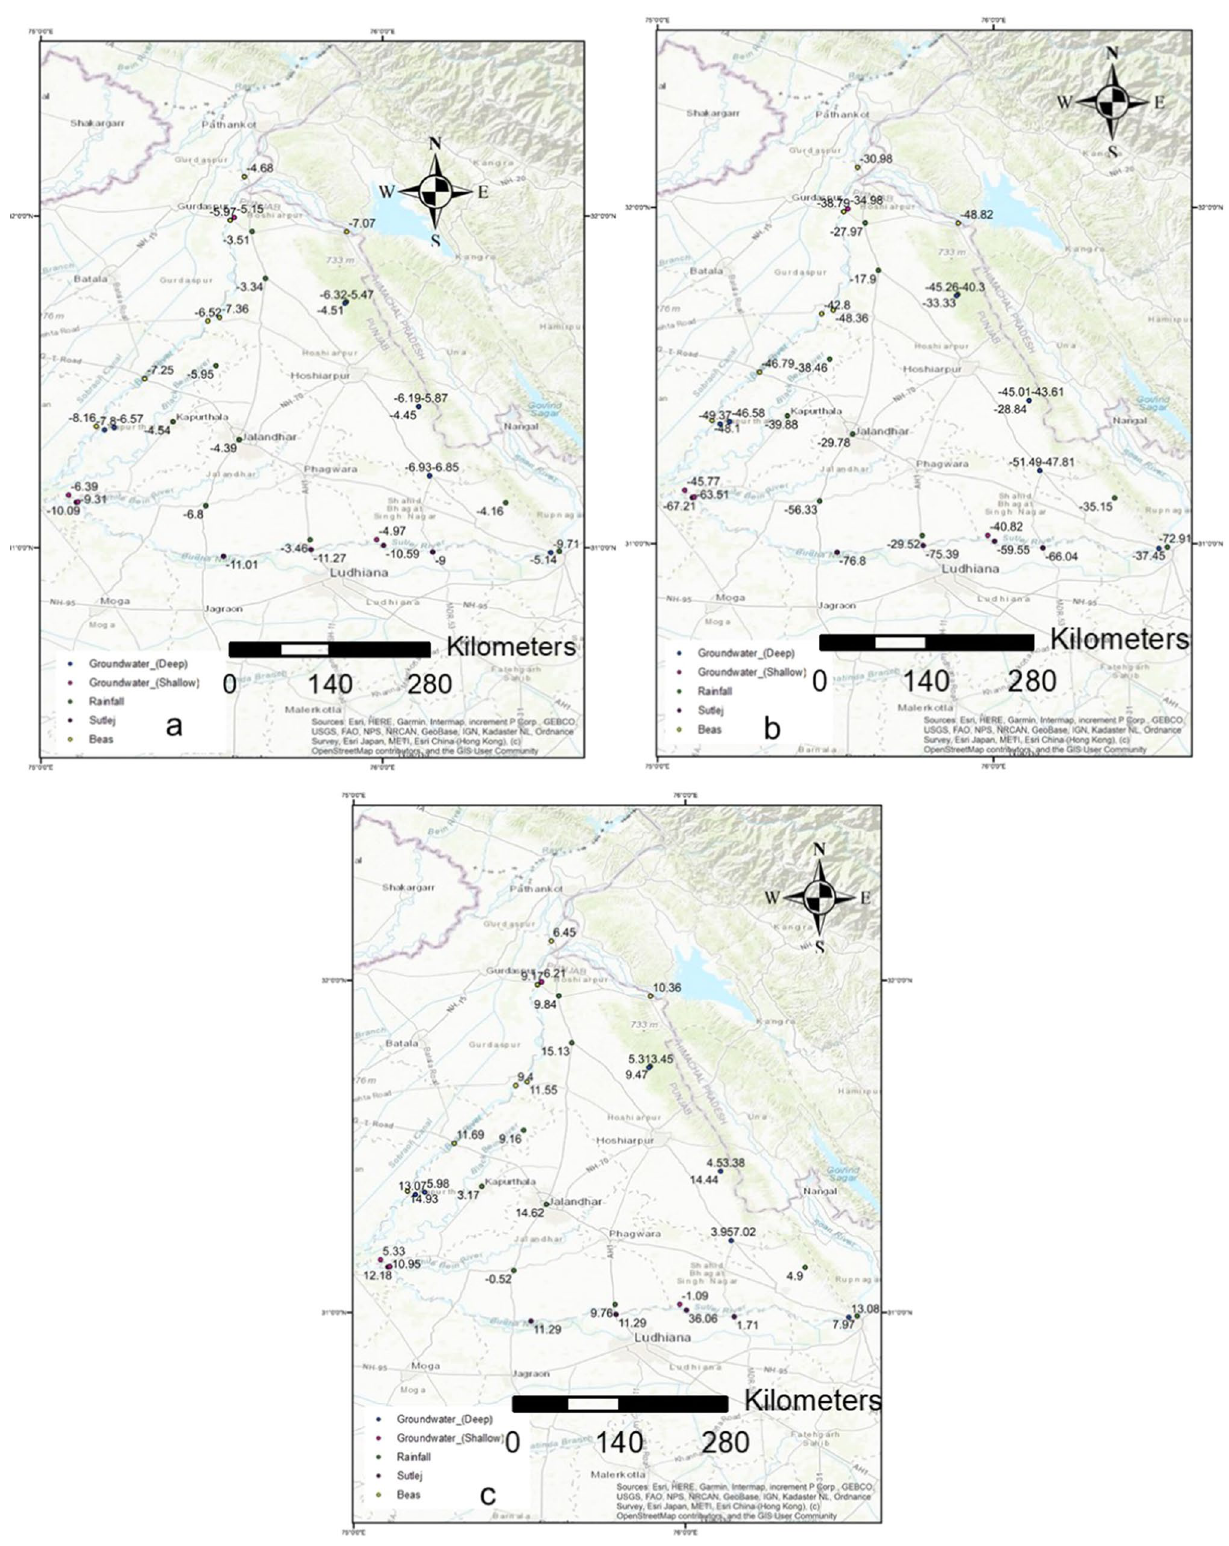
Fig. 6 Spatial distribution of δ 18 O (‰) of the river Sutlej, the river Beas, rainfall and groundwater. Spatial distribution of δ 2 H (‰) of the river Sutlej, the river Beas, the rainfall, and the groundwater. Spatial distribution of d-excess (‰) of the river Sutlej, the river Beas, the rainfall and the